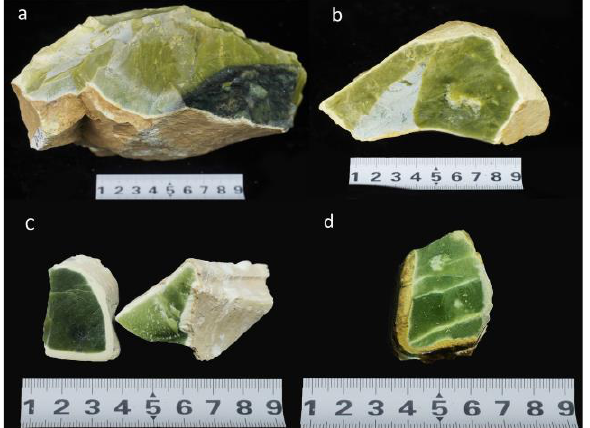
Figure 1. Sample photographs. ( a , b ) Serpentine jade samples collected from Gaotai area, Ji’an Province; ( c , d ) Serpentine jade samples with weathering rind after crushing.